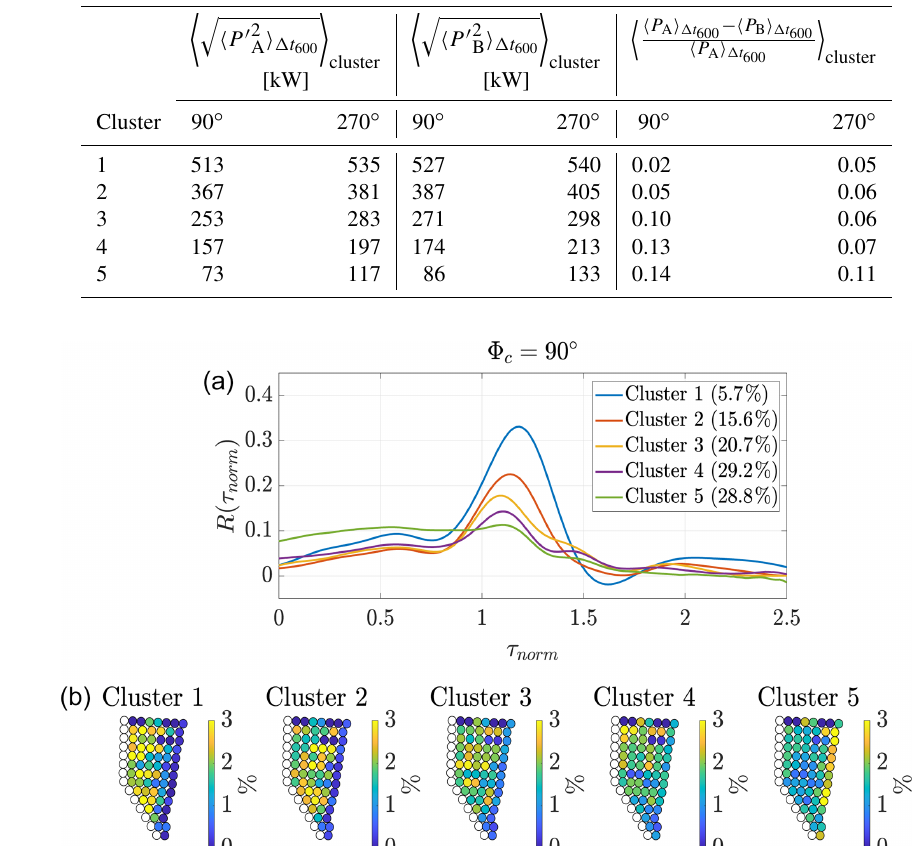
Table 4. Cluster centroids for wind direction intervals around 90 and 270 ◦ with A as the upstream wind turbine and B as the downstream (cid:113) (cid:104) P (cid:48) 2 (cid:105) (cid:49)t is the standard deviation of the power output fluctuations of wind turbine A over 600s intervals (cid:49)t 600 (analogue wind turbine. A 600 for wind turbine B for the same 600s intervals, respectively). (cid:104) P A (cid:105) (cid:49)t and (cid:104) P B (cid:105) (cid:49)t are the average power output of wind turbines A and 600 600 B over the same 600s intervals. (cid:104) ... (cid:105) cluster denotes the average of the statistics over all available time intervals of the wind turbine pairs within a cluster. Note that 90 and 270 ◦ again refer to 20 ◦ wind direction intervals from 80 to 100 ◦ and from 260 to 280 ◦ .